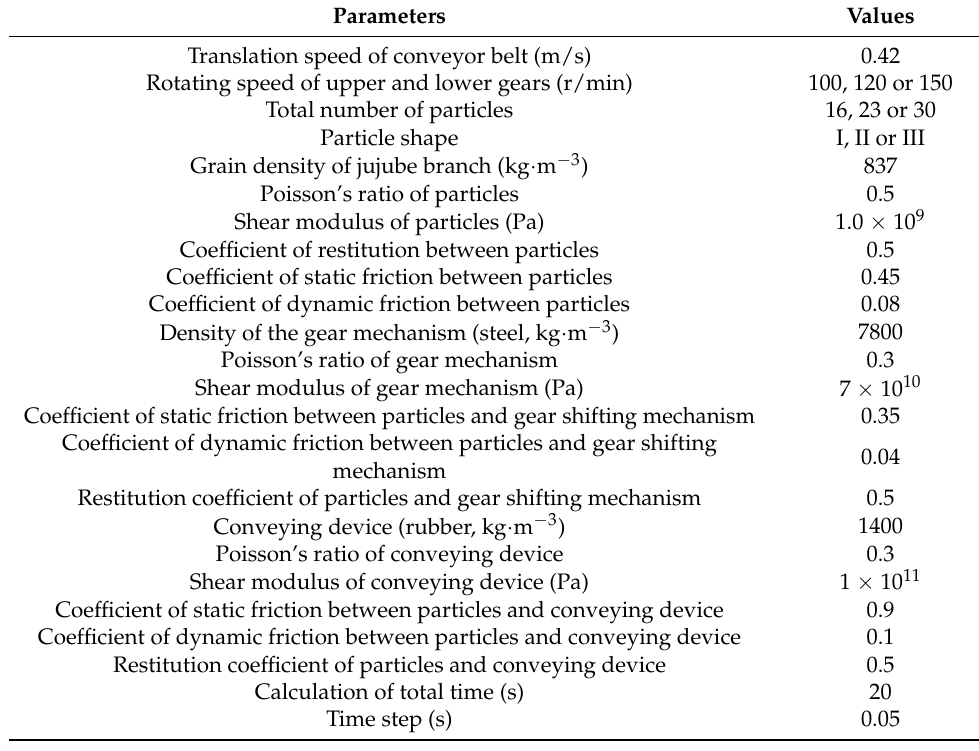
Table 2. Material parameters used in simulation.